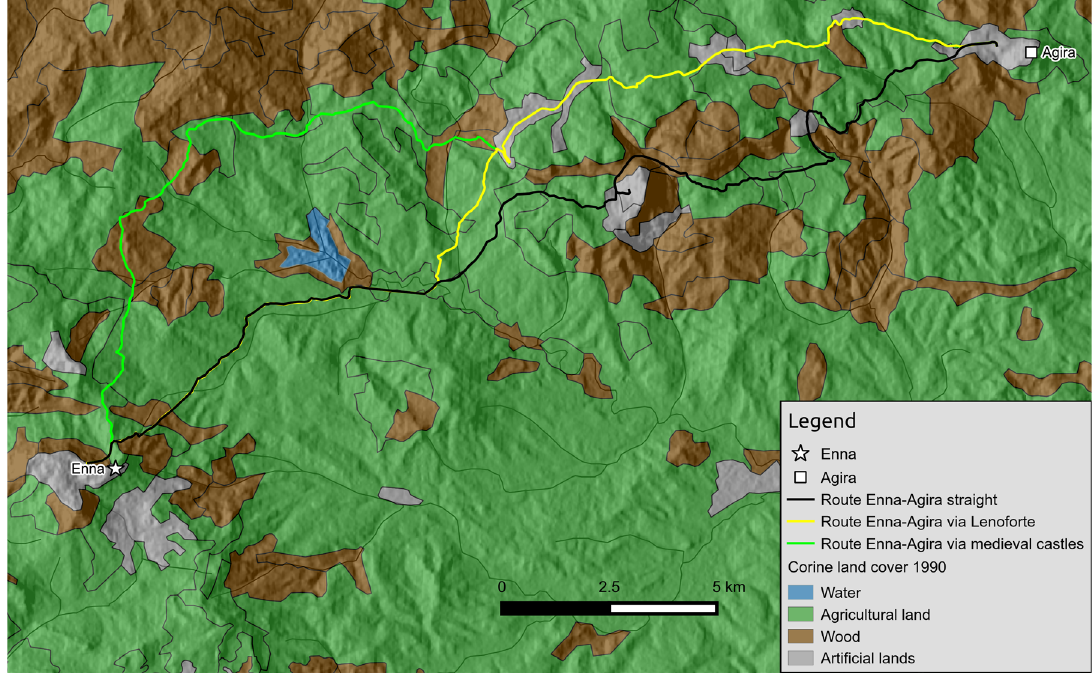
Fig. 3. Corine land cover soil map est. 1990 and the evaluated